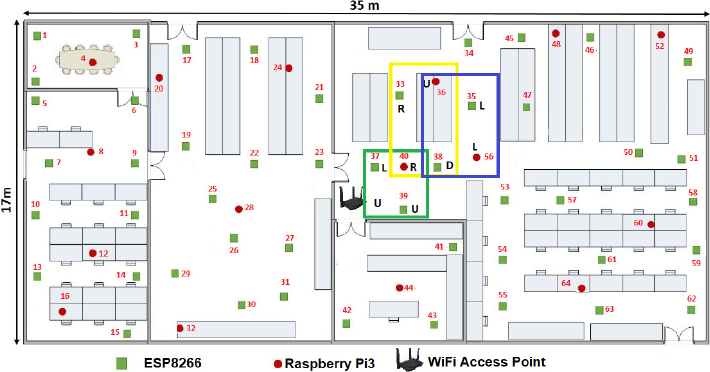
Figure 14. MCU 36 ( t 2 ) as the MCU seed using the axiom R −→ DRRU